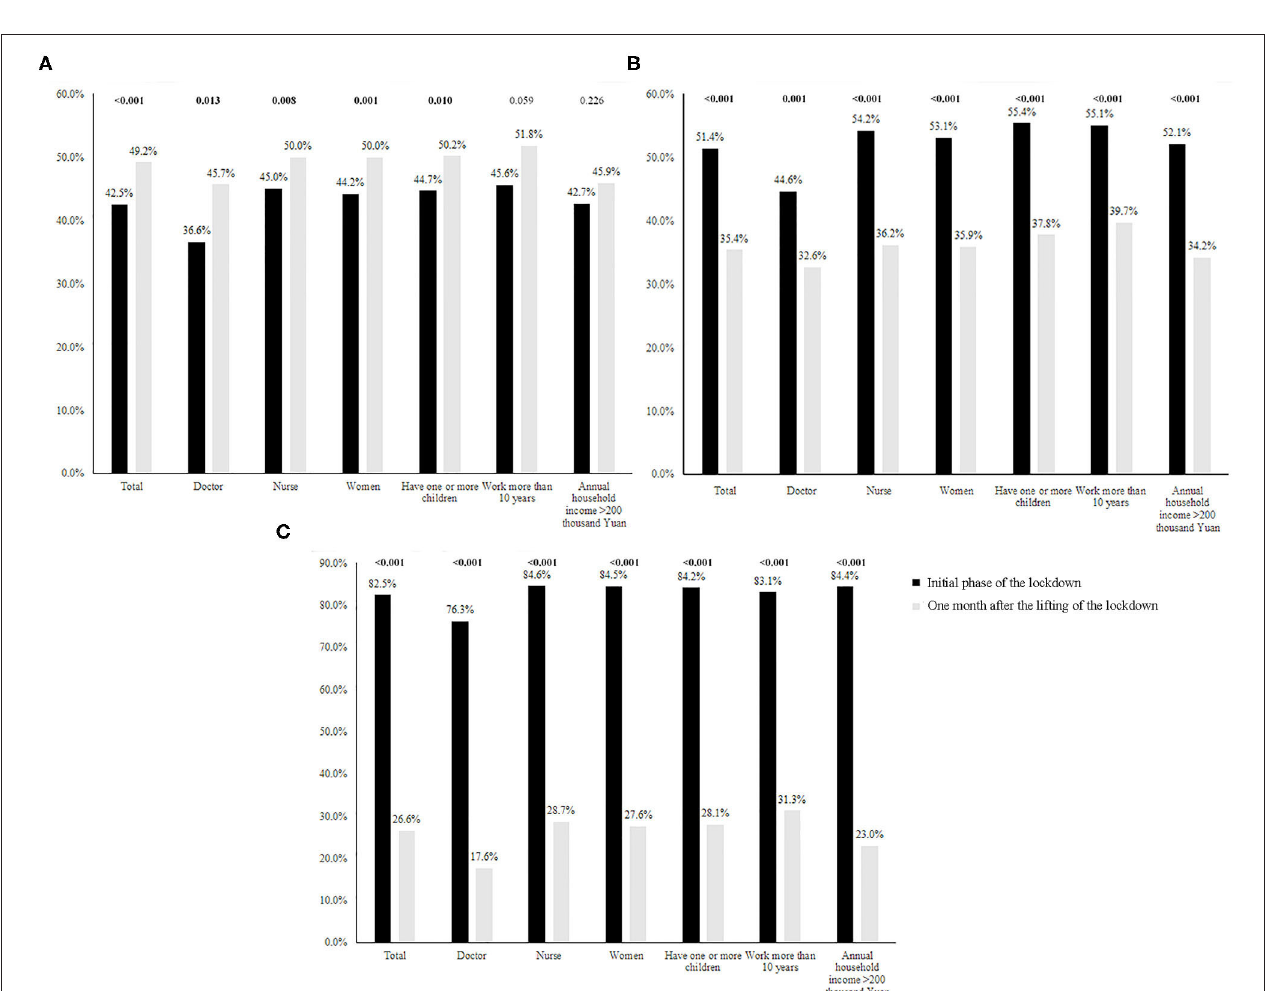
FIGURE 2 | Depressive symptoms, anxiety symptoms, and stress in the initial phase of the lockdown and 1 month after the lifting of the lockdown. (A) Depression. (B) Anxiety. (C) Stress.